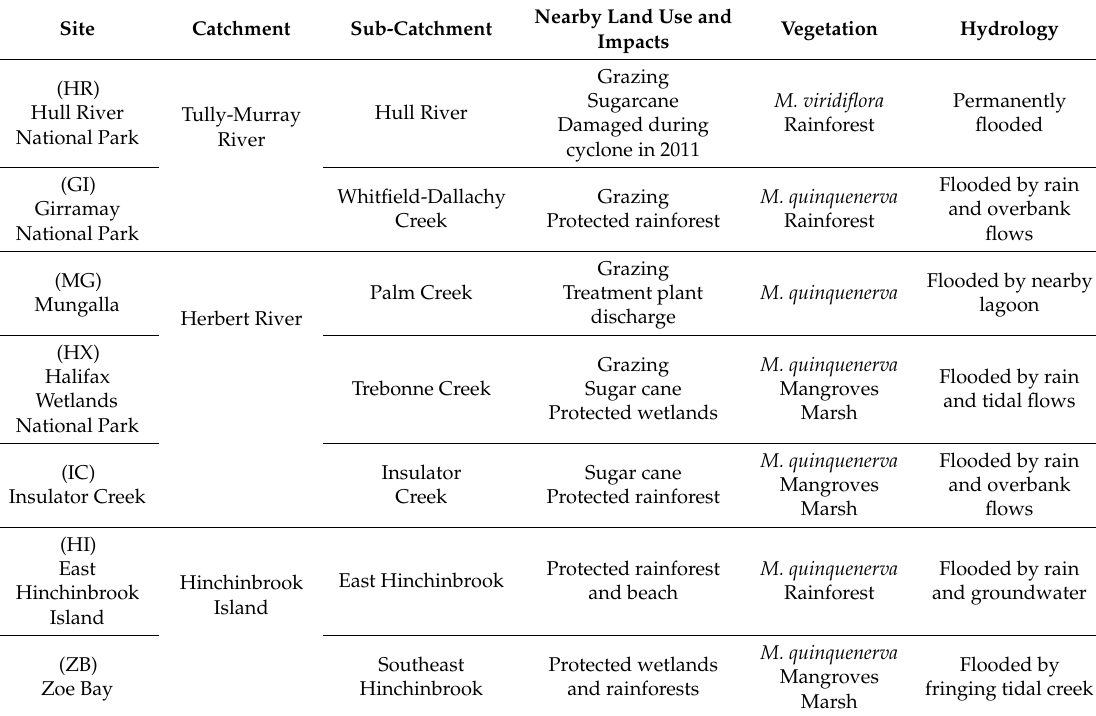
Table 1. Characteristics of the catchments, sub-catchments, vegetation and hydrology for sampling sites at seven forested floodplain wetlands dominated by Melaleuca spp. in northeast